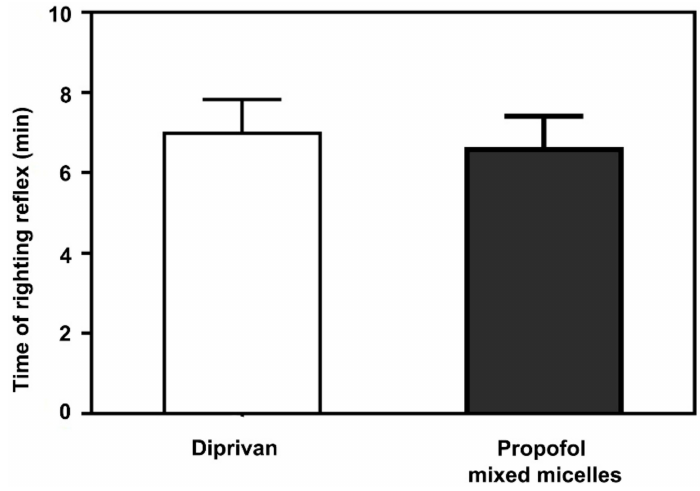
Figure 7. In vivo anesthetic action of propofol-mixed micelles and Diprivan ( n = 9).